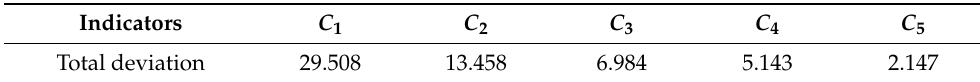
Table 6. Total deviation of experts on the first-level indicators.